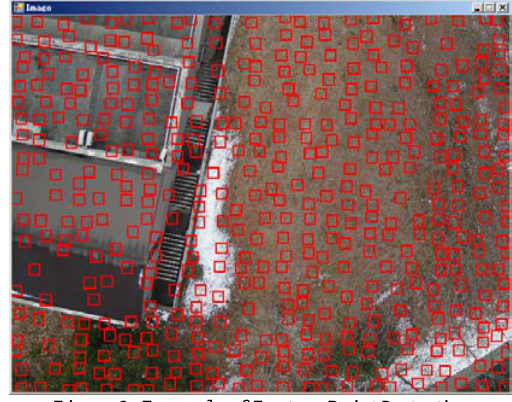
Figure 3. Example of Feature Point Detection